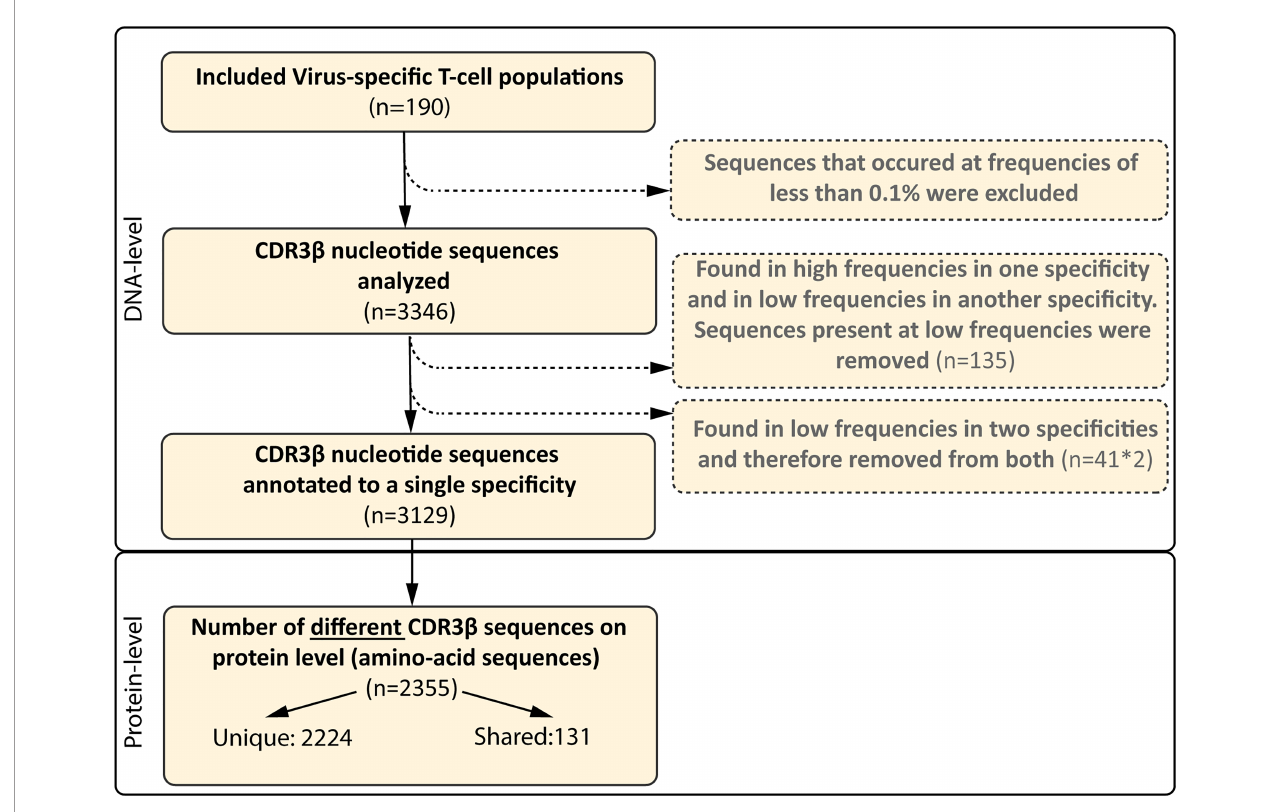
FIGURE 1 | Flowchart of included and excluded CDR3 b nucleotide and AA-sequences. In total, 190 different virus-speci fi c T-cell populations were FACsorted using pMHC-tetramers, followed by a short-term in vitro stimulation. The CDR3 b nucleotide-sequences were determined using next-gen Illumina sequencing. CDR3 b nucleotide-sequences that occurred at a frequency of less than 0.1% in each sample were excluded. CDR3 b nucleotide-sequences that were identical and present in two different speci fi cities, but present at high frequencies in one speci fi city, were only removed from the speci fi city that contained the sequences at very low frequencies (0.1-0.5%; n=135). CDR3 b nucleotide-sequences that were identical and present in two different speci fi cities at low frequency were considered contamination and removed from the library (82 sequences, 41 different-sequences). The numbers of different CDR3 b AA-sequences that were encoded by the CDR3 b nucleotide-sequence are shown at protein level. We then assessed how many CDR3 b -AA-sequences were found in multiple individuals (shared) and how many were only found in a single individual